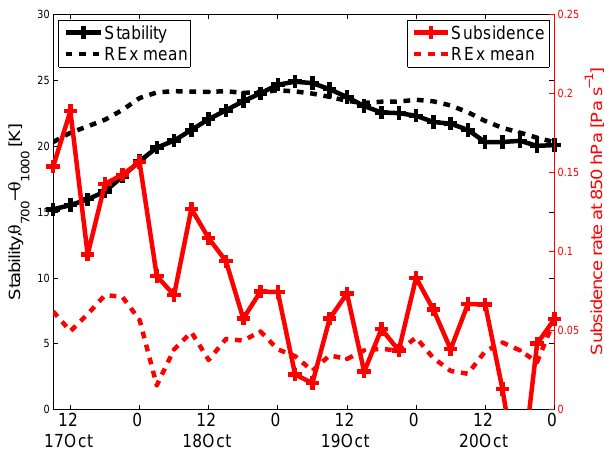
Fig. 10. Average stability (black) and 850hPa subsidence rate (red) interpolated over Hook1 2-D trajectories (same trajectories used in Fig. 8). Stability is defined as the difference in potential temperature between 700hPa and 1000hPa ( θ 700 – θ 1000 ) and subsidence is the grid-scale vertical velocity in pressure units (Pas − 1 ). Crosses mark the Anth simulation and dashed lines denote the REx mean at the locations and times of day of the Hook1